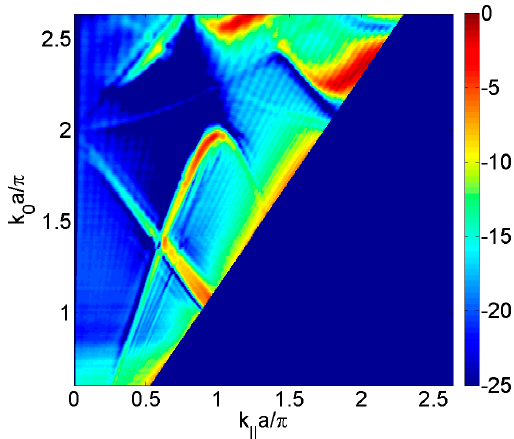
Figure 5. Measured transmitted sound power coefficient, τ , as a function of the parallel wavevector k ‖ · a / π in the Γ X direction and the normalized frequency k 0 · a / π , for the square distribution of circular holes having diameter, d , of 1 mm and a unit cell period, a , of 3 mm and the holes filled with air (air-solid phononic plate). The transmitted sound is represented in dB scale.